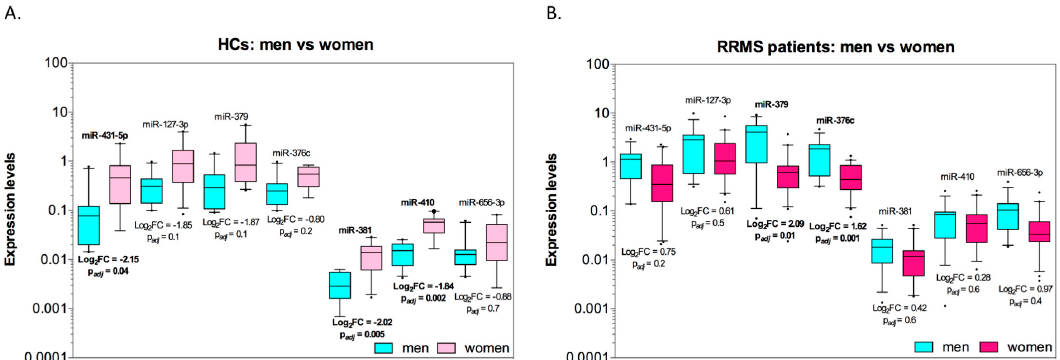
Figure 3. Expression levels of miRNAs in peripheral blood mononuclear cells of men and women (separately in healthy control (HCs) group and relapsing-remitting multiple sclerosis (RRMS) group), as determined by RT-qPCR. Box plots show the minimum, maximum, median and interquartile range for data (Log2 scale) from all individual samples. The points denote outliers. MiRNA expression was calculated relative to endogenous RNU6B using ∆∆ Ct method. Tukey-test was used to estimate statistical significance between compared groups.